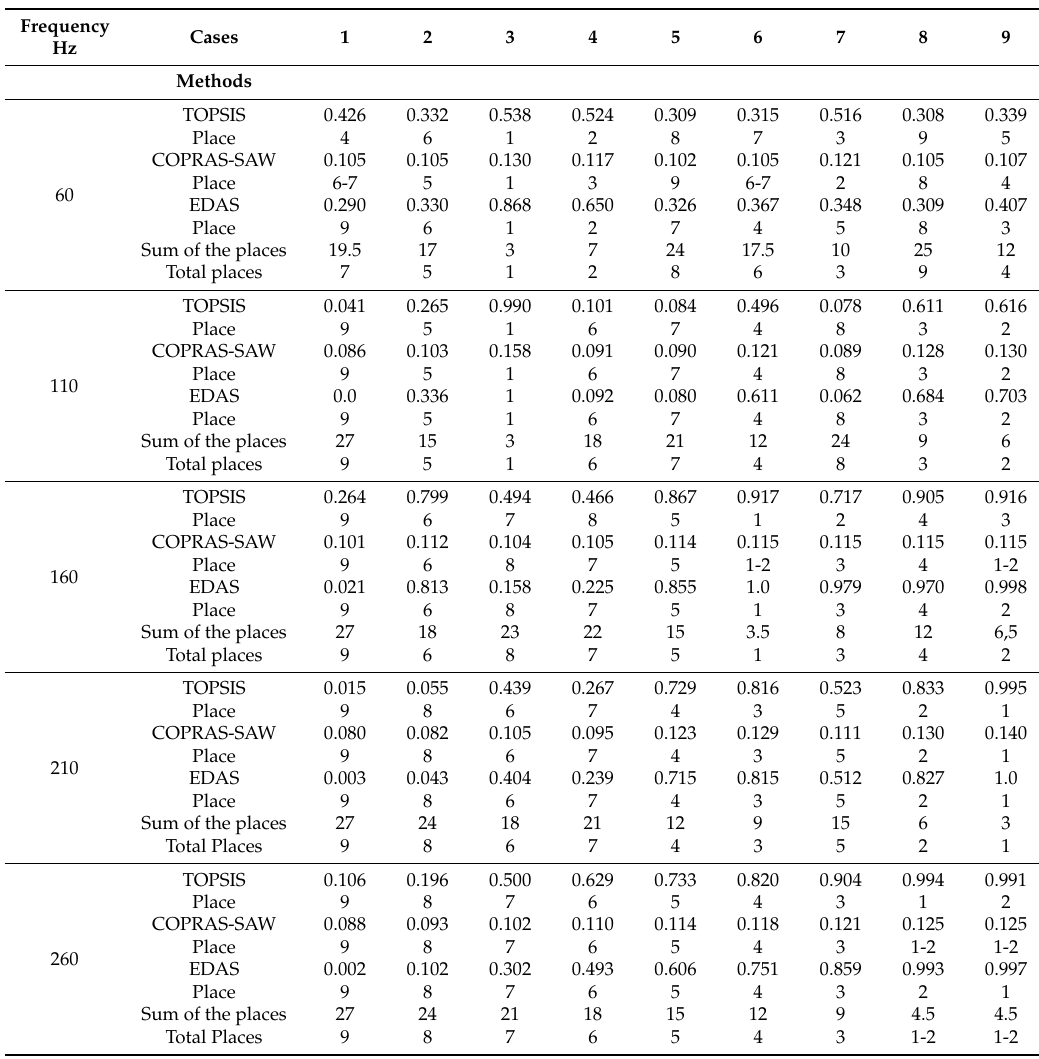
Table A3. Results of MCDM methods